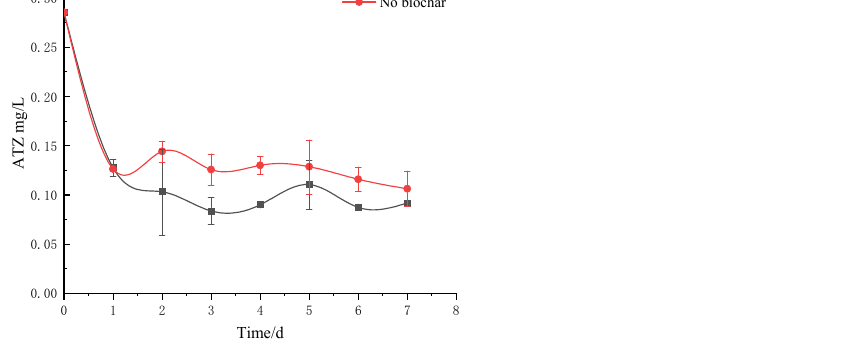
Figure 6. Changes in ATZ content in the outlet water with time.